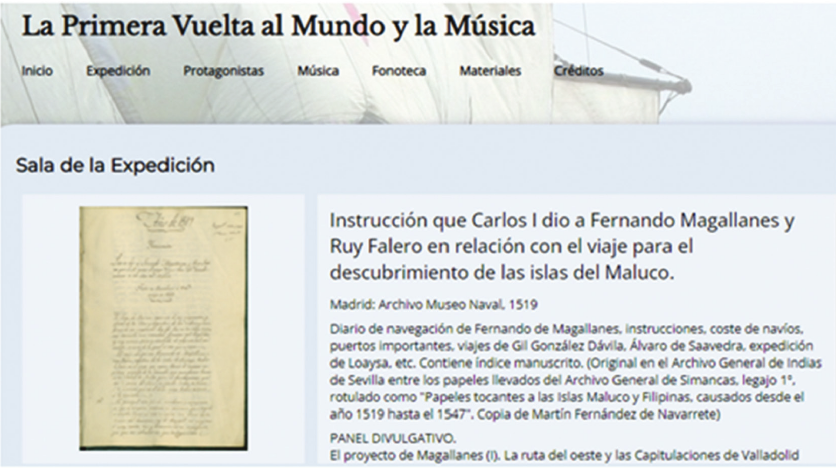
Fig. 1: Virtual exhibition ‘La primera vuelta al mundo y la música’. Source: www.